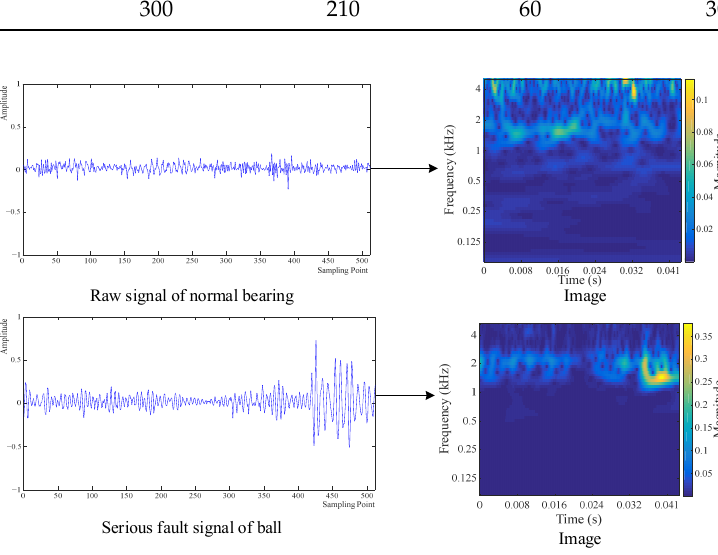
Figure 5. Transformed results.